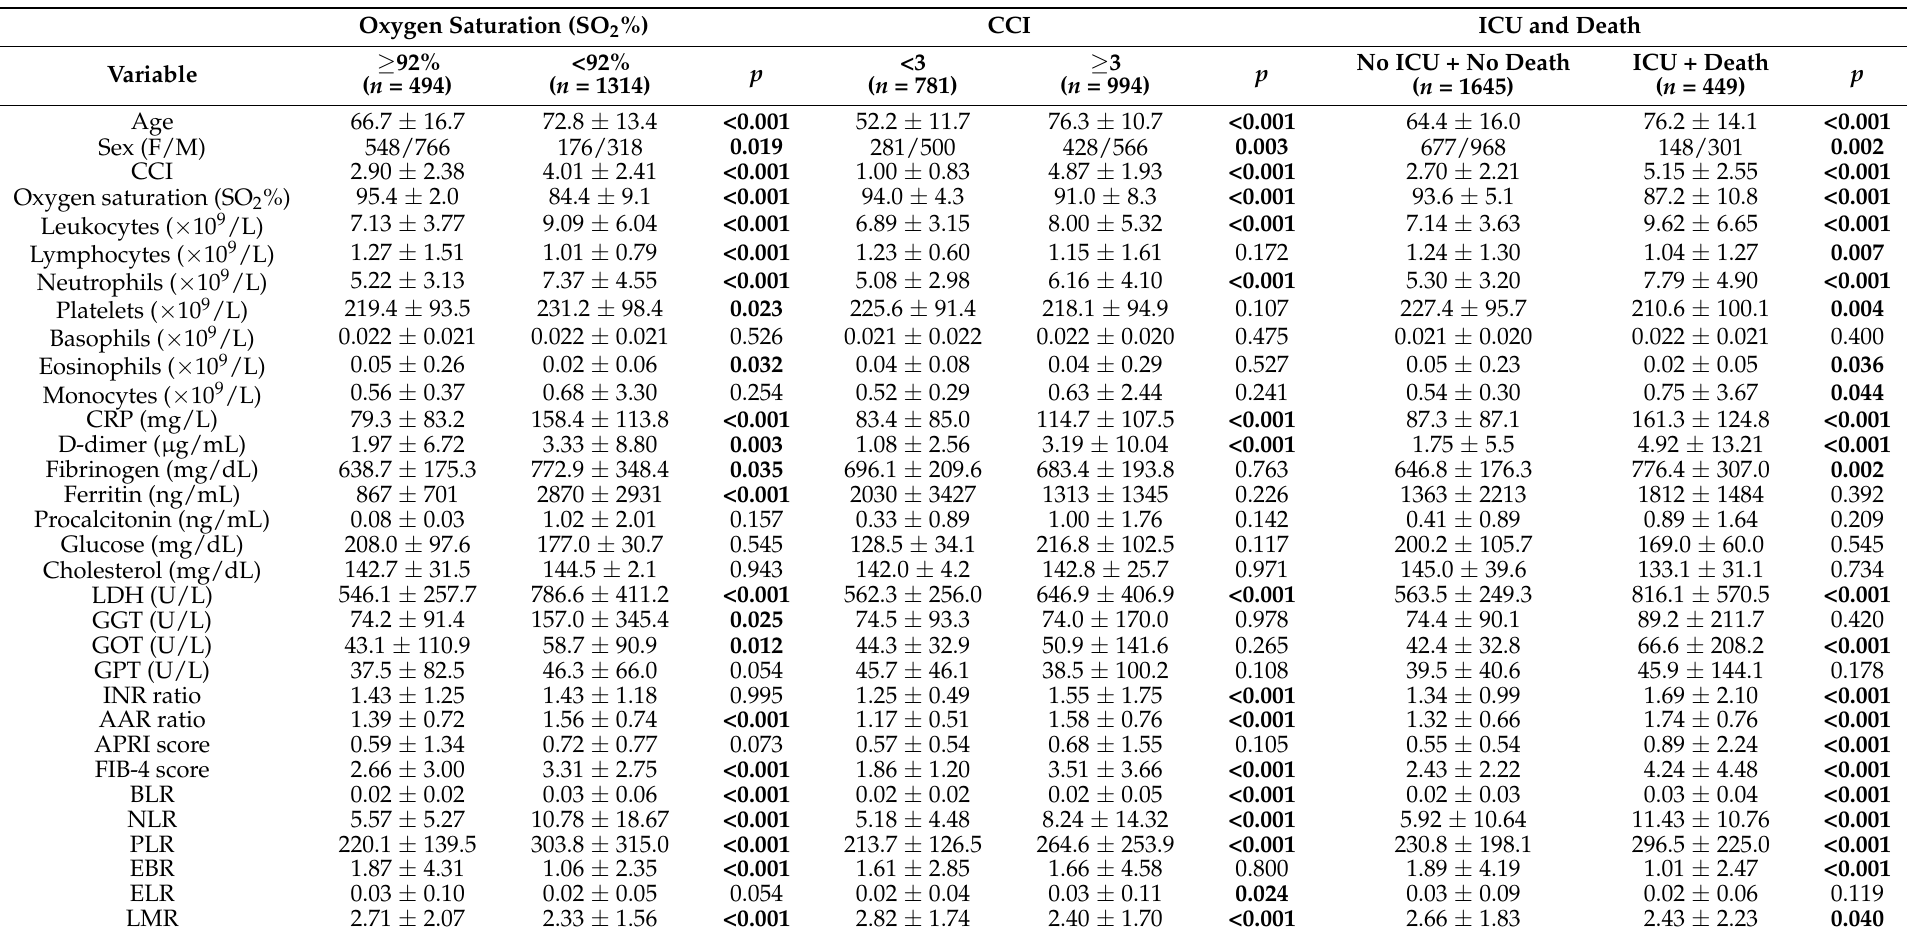
Table 1. Clinical and phenotypical characteristics of COVID-19 patients based on respiratory insufficiency (oxygen saturation), comorbidities (CCI), and ICU plus death outcomes.